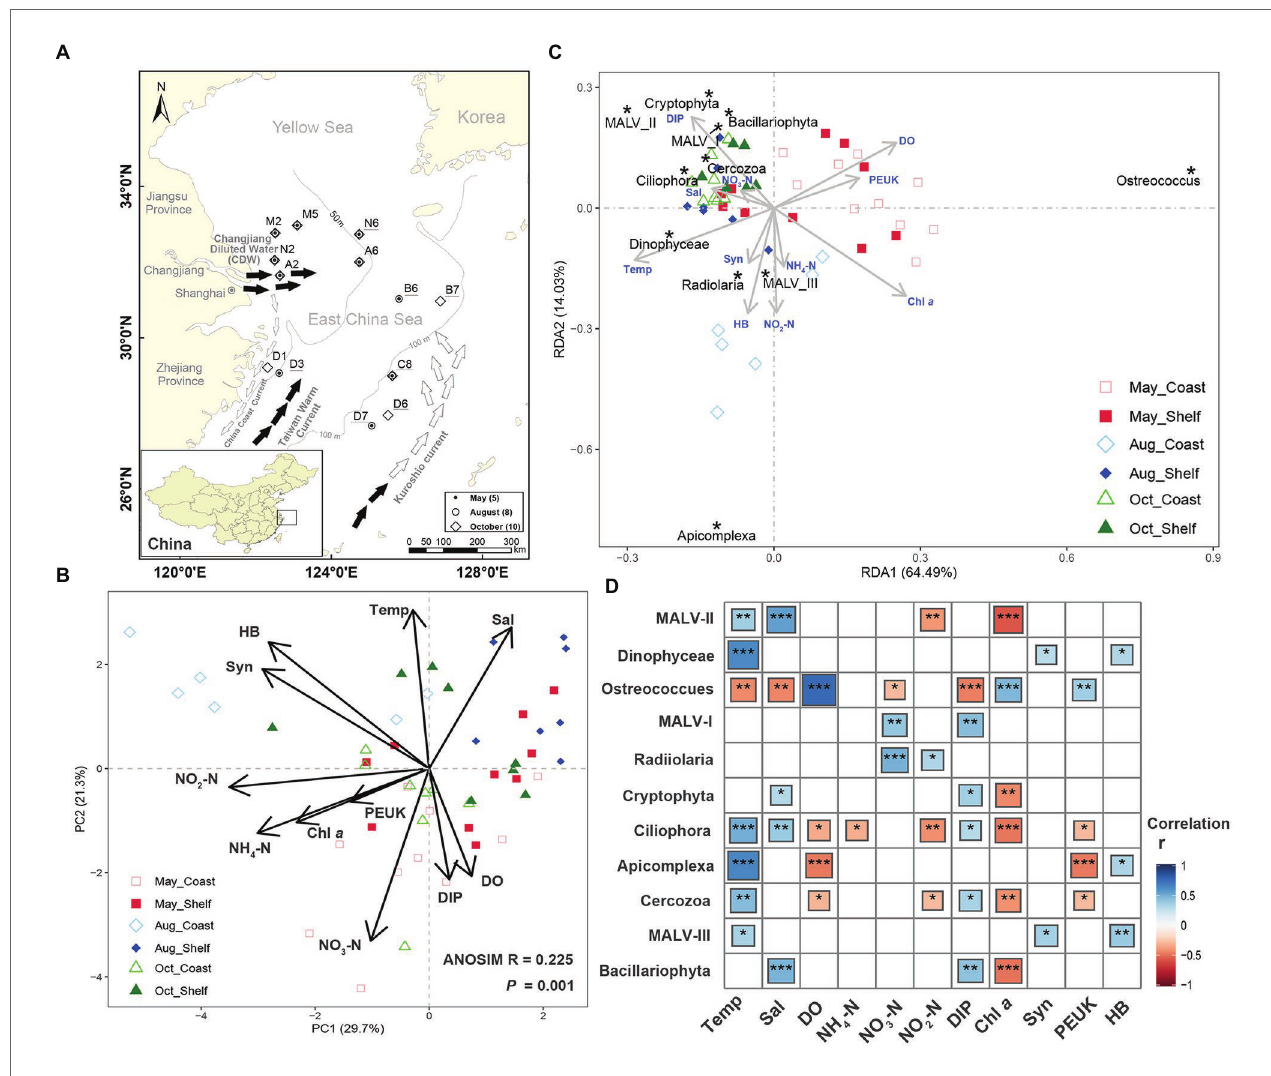
FIGURE 1 | Study area, spatiotemporal variation in environmental conditions, and the relationship with protist dominant lineages across three seasonally representative months and two habitats. (A) Location of the 13 sampling stations in the studied area in 3 months in 2013. Water samples in each station were simultaneously collected from both surface and bottom layers. Symbols indicate sampling months. Sample labels with underline indicate stations in shelf area (deeper than 50 m), whereas others represent stations in coastal area (lower than 50 m). The summer currents are indicated with black arrows, whereas white arrows represent spring and autumn currents. (B) Ordination biplots of the principal component analysis (PCA) of all environmental variables. (C) Redundancy analysis based on 37 lineages of protist and the environmental variables. Only 11 dominant taxa (percentage of reads >1% in all 60 samples) were marked in the figure. (D) Correlation analyses among the environmental factors and the relative abundance of the 11 dominant lineages (percentage of reads >1% in all 60 samples). Asterisks inside the squares indicate significant correlations (*** p < 0.001; ** p < 0.01; and * p < 0.05). Environmental codes are as follows: Temp, temperature ( ° C); Sal, salinity (psu); DO, dissolved oxygen (mg/L); NH 4 -N, ammonia nitrogen ( μ mol/L); NO 3 -N, nitrate ( μ mol/L); NO 2 -N, nitrite ( μ mol/L); DIP, dissolved inorganic phosphorus ( μ mol/L); Chl a , chlorophyll a ( μ g/ml); Syn, Synechococcus (cells/ml); PEUK, pico-eukaryotes (cells/ml); HB, heterotrophic bacteria